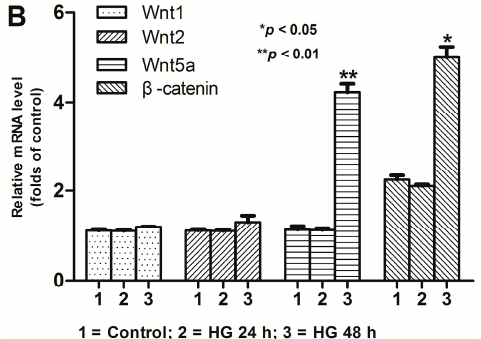
Figure 2. Activation of the Wnt/ β -catenin pathway induced by high glucose in podocytes Podocytes incubated with HG for 24 and 48 h, respectively. ( A ) Reverse transcription-PCR (RT-PCR) demonstrating an non-altered expression of Wnt1 and Wnt2 and an increased expression of Wnt5a and β -catenin compared to control; ( B ) corresponding statistic histogram of Wnt1, Wnt2, Wnt5a and β -catenin. Data representative of three independent experiments. * p < 0.05, ** p < 0.01 compared to control group and HG 24 h group